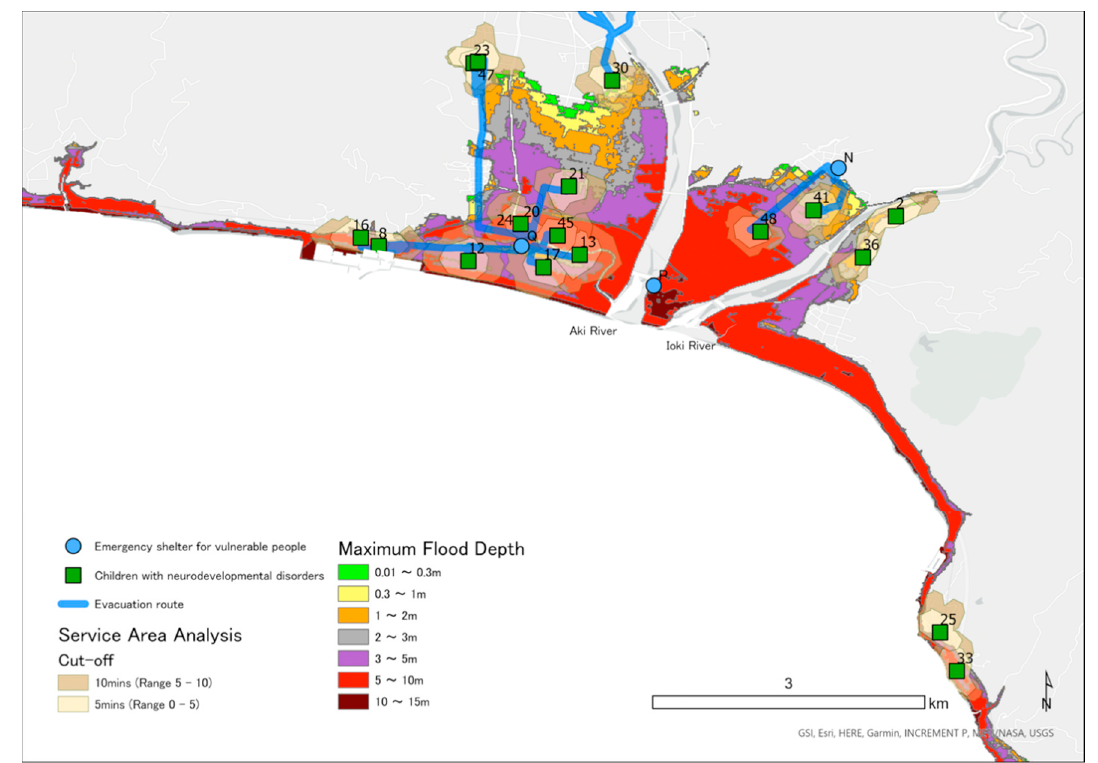
Figure 3. Service area analysis of emergency shelters for vulnerable people (ESVPs) in Konan and evacuation routes to nearby ESVPs.